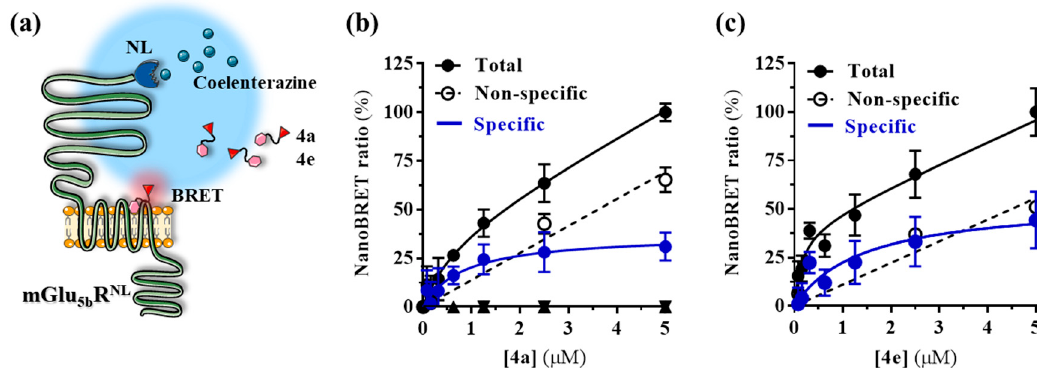
Figure 6. Determination of the binding affinity of 4a and 4e at mGlu 5b R using the nanoBRET assay. ( a ) Illustrative representation of the nanoBRET assay in which a nanoluciferase linked to the N-terminal part of the mGlu 5b R (donor) emits light at 490-10 nm in presence of coelenterazine. The light excites the BODIPY attached to the ligand (acceptor), which subsequently emits fluorescence at 650-80 nm. ( b , c ) NanoBRET saturation binding curves obtained by challenging mGlu 5b R NL expressing HEK293T cells with increasing concentrations of 4a ( b ) or 4e ( c ) in the absence (black circles) or presence (white circles) of 10 µ M MTEP for 1 h at 37 ◦ C. The specific binding curve (blue circles), the K D and the B max is shown for each ligand. The represented data are mean ± SEM of three independent experiments each performed in triplicate. Figure designed using image templates from [20].